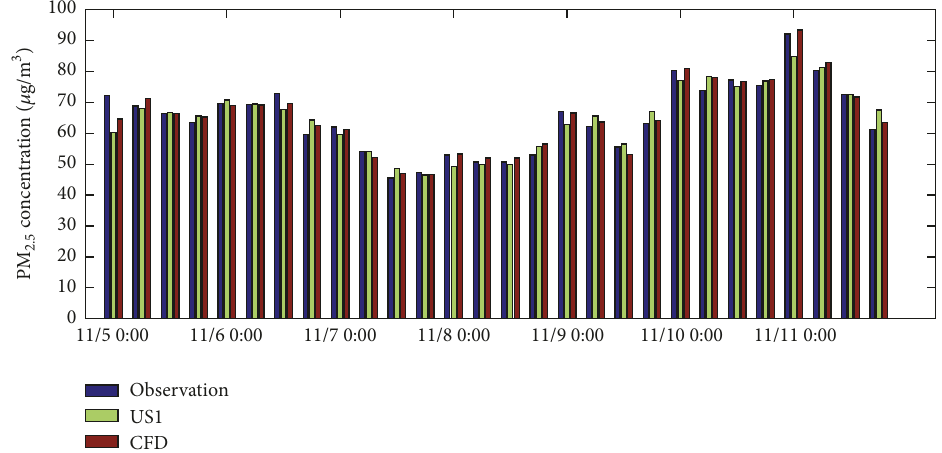
Figure 8: The averaged PM 2.5 concentrations in China from Nov. 5 to Nov.